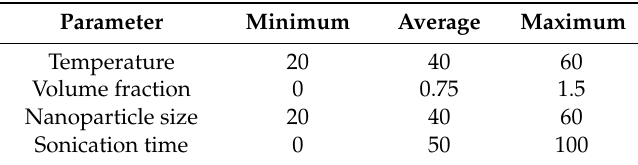
Table 2. The minimum, average and maximum values for the input